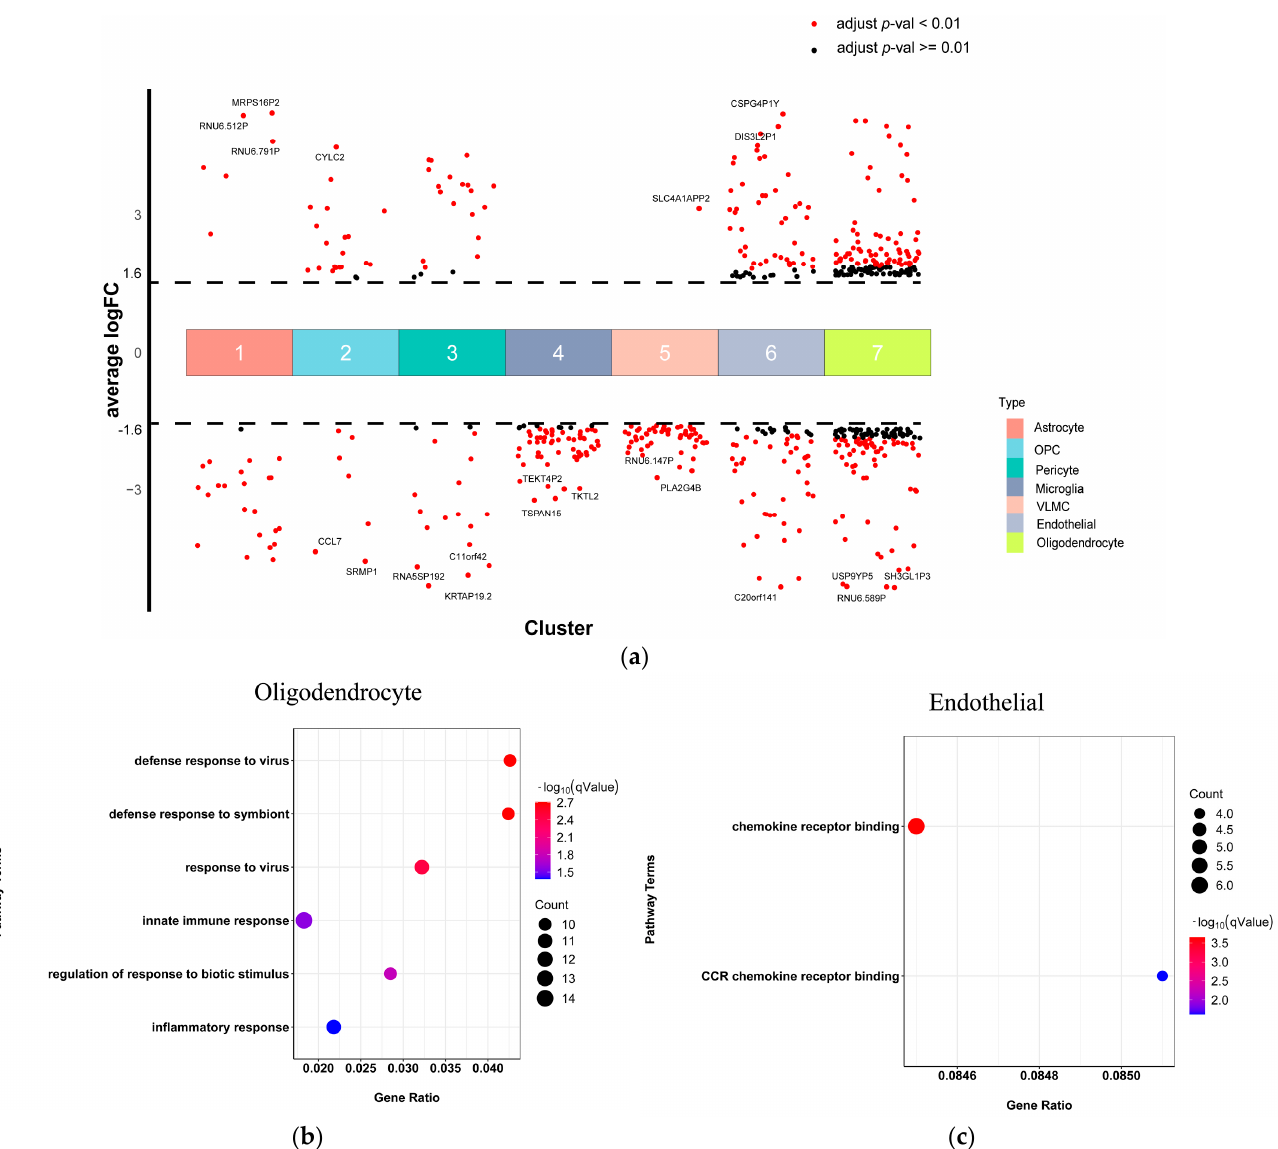
Figure 4. Non-neuronal type-special DEGs and related pathways of scRNA-seq. ( a ) Differential gene expression analysis showing up- and down-regulated genes across all seven non-neuronal clusters. An adjusted p -value < 0.01 is indicated in red, while an adjusted p -value ≥ 0.01 is indicated in black; ( b , c ) The top significantly GO terms. The x-axis represents the gene ratio, the y-axis indicates the items of GO, the color of dots represents the value of − log (FDR adjusted p -value), and the size of dots represents the count of genes.